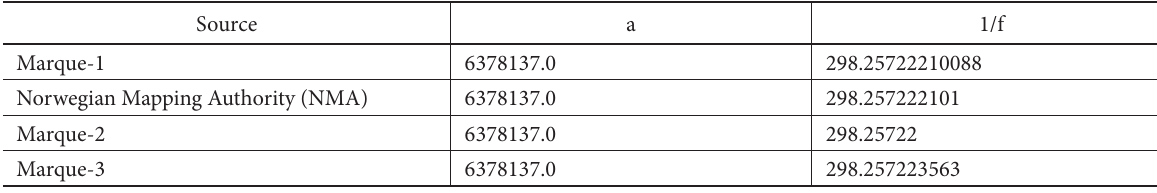
Table 1. Ellipsoid parameters from different sources